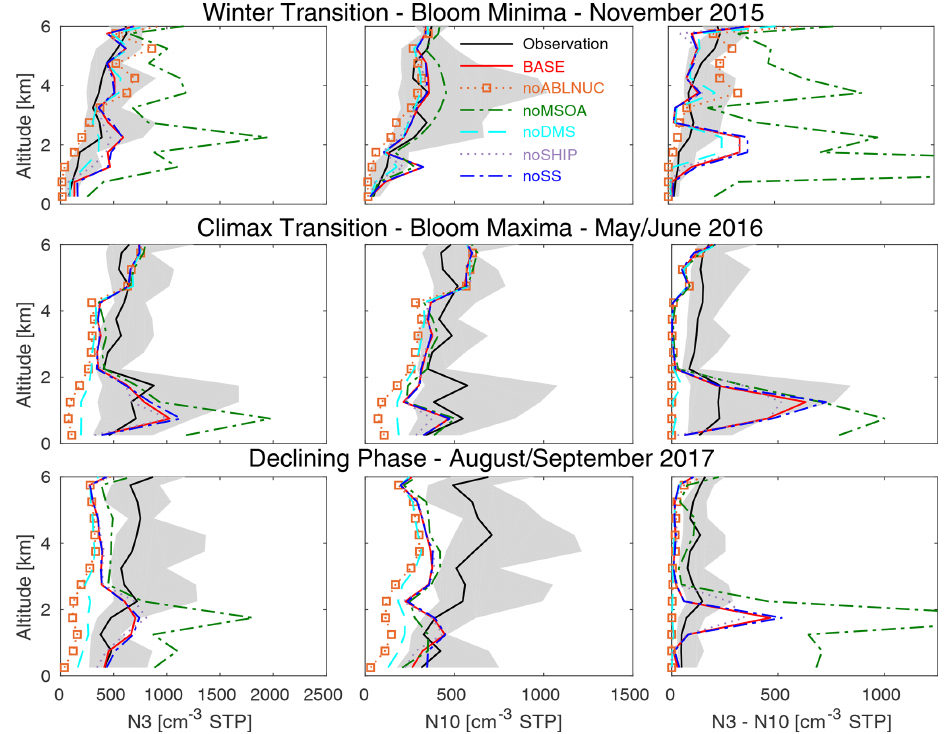
Figure 4. Vertical profiles of NAAMES campaign-median total number concentrations for particles with diameters larger than 3nm (N3), 10nm (N10), and between 3 and 10nm (N3–N10) from CPC observations aboard aircraft at standard temperature and pressure (STP) (black, with 25th–75th percentiles in grey) and for the six GEOS-Chem-TOMAS simulations described in Table 1 (color-coded as shown in the legend). All measurement and model output is binned at 500m resolution, and campaign-median values are plotted at the midpoint of each bin starting at 250m above the surface. Lines show linear interpolation between these